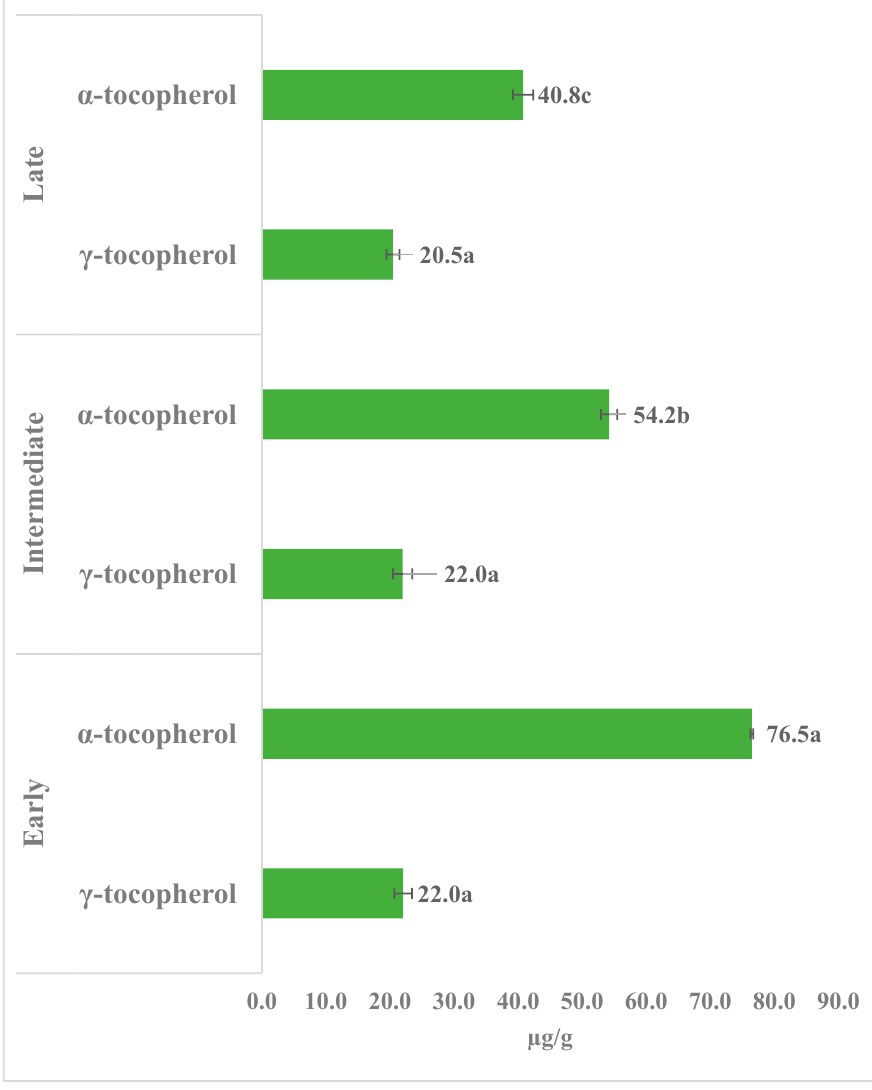
Figure 6. Content (µg/g egg yolk; fresh weight) of γ -tocopherol and α -tocopherol in the yolks from early, intermediate, and late-age laying hens. The values are the mean ± standard deviation of six independent experiments. Different letters (in data labels) represent significant differences ( p < 0.05) between early, intermediate, and late-age laying hens.